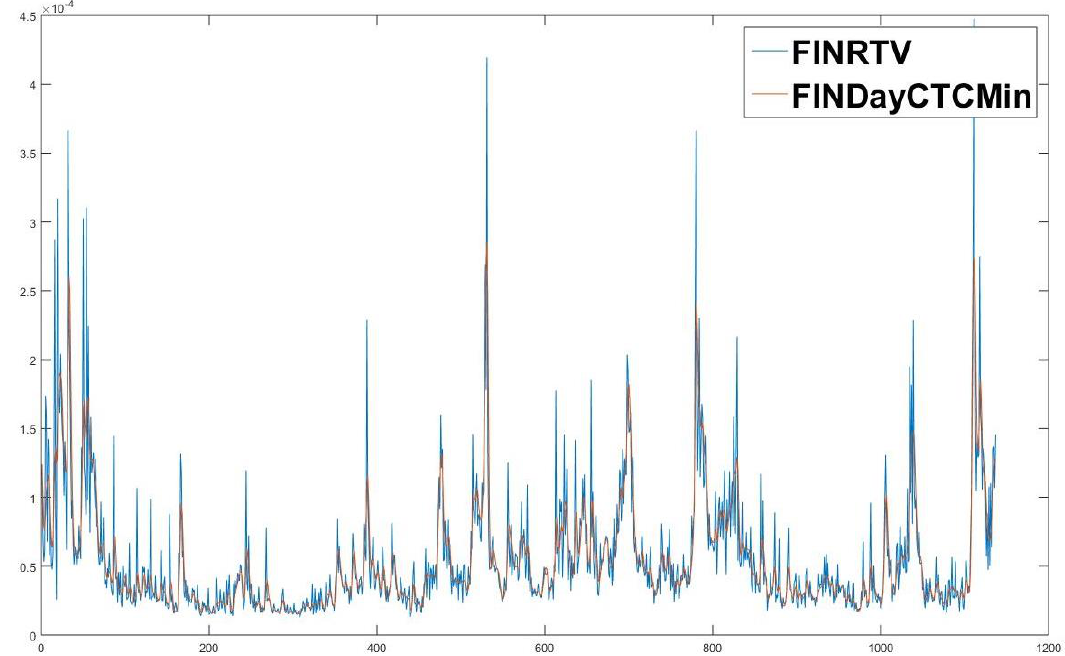
Figure 2. Model CTCM-RTV-D Estimation for FINRE. The horizontal line is the timeline, and the perpendicular line is the volatility estimator. The actual values are represented by the blue line, while the estimated values are represented by the orange line. We find that the estimated values are close to the actual values, although the volatility is high throughout the whole